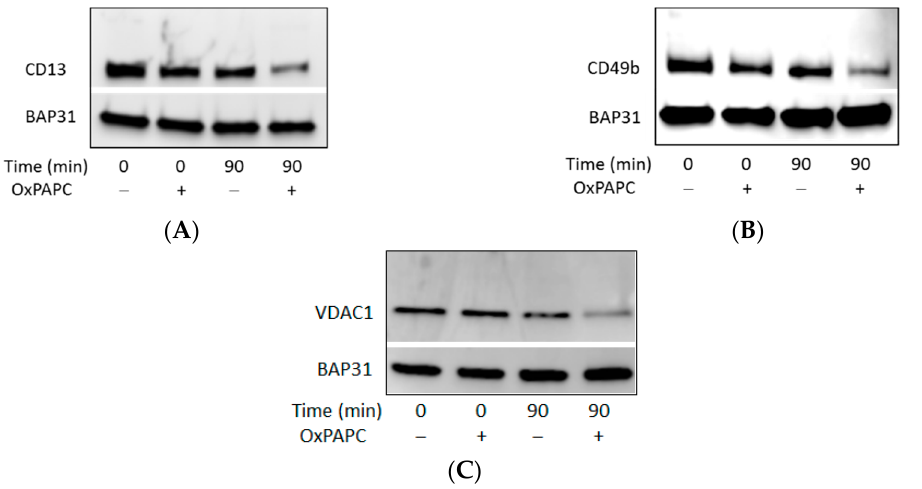
Figure 10. Western blot analysis of ( A ) Aminopeptidase N (CD13), ( B ) Integrin α -2 (CD49b) and ( C ) VDAC-1 after treatment of HUVECs with OxPAPC. Samples were treated for 0 or 90 min with a final OxPAPC concentration of 0 or 80 µmol/L. BAP31: B-cell receptor-associated protein 31 which was identified to not be modified by OxPAPC.